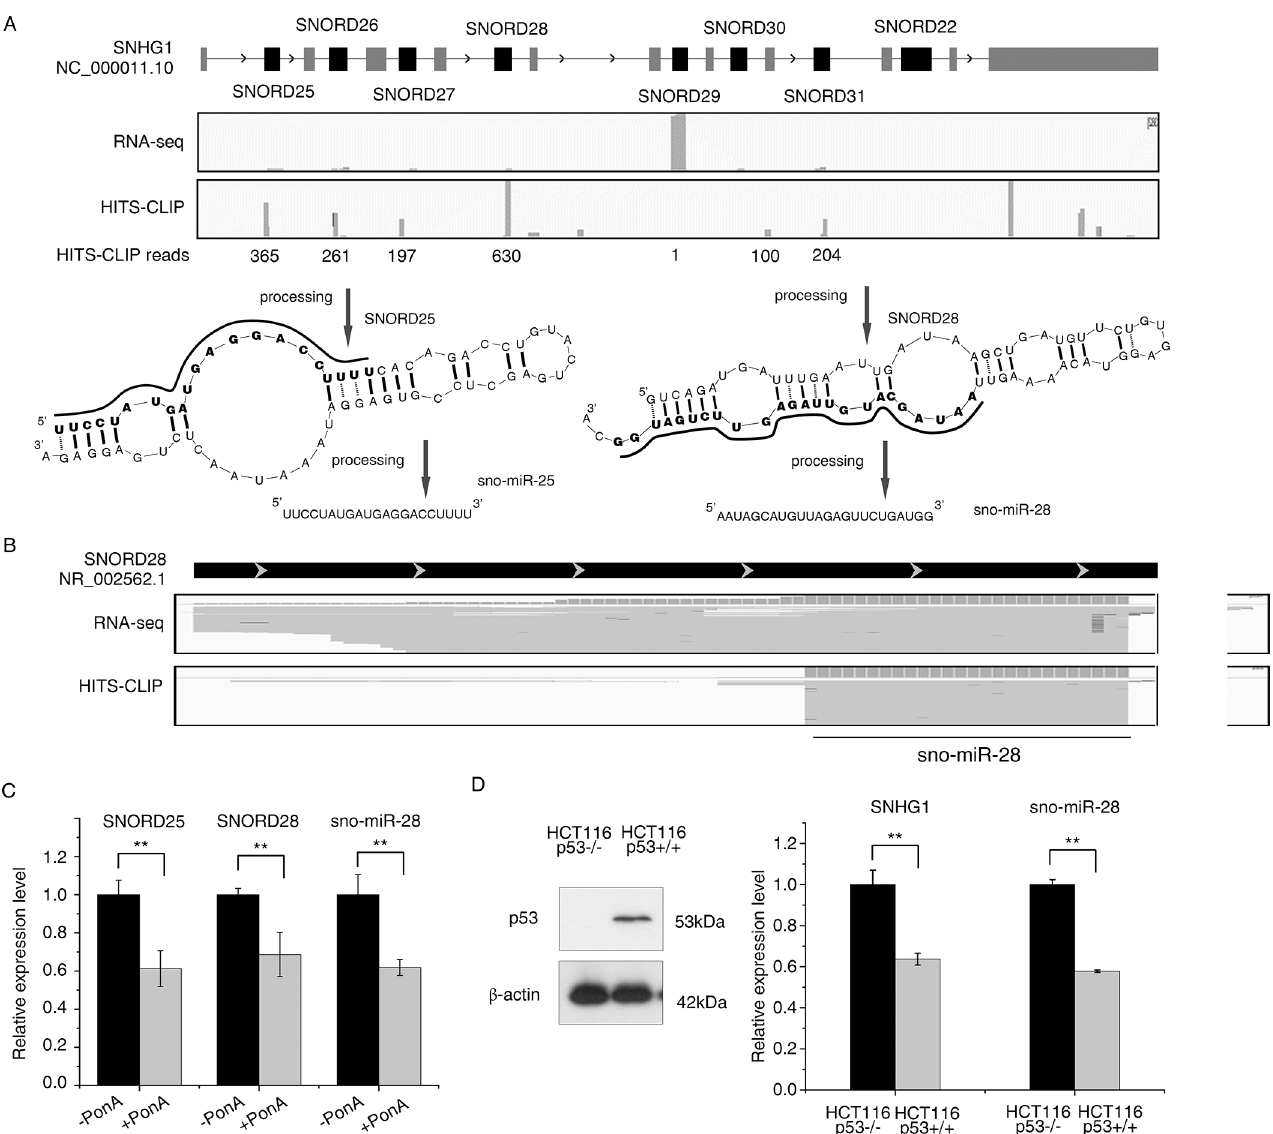
Fig 2. p53 repressed snoRNAs are processed into miRNAs. (A) SNHG1 is processed into snoRNAs including SNORD25 and SNORD28. The top panel shows RNA deep-sequencing and HITS-CLIP (high throughput sequencing of crosslinked and immunoprecipitated RNA) results at the SNHG1 genomic loci. Predicted stem-loop folding of SNORD25 and SNORD28 are shown. The regions marked in bold are processed into sno-miRNAs which can bind to Argonaute proteins, which was confirmed by RNA deep-sequencing and HITS-CLIP results. The solid lines between chains represent hydrogen bonds between adenine (A)-uracil (U) pairs and guanine (G)-cytosine (C) pairs, whereas dashed lines represent G-U pairing. (B) RNA-seq and HITS-CLIP mapping reads across the SNORD28 region is shown indicating precise binding of sno-miR-28 to AGO (C) p53 was induced by PonA treatment in inducible H1299 cells, and the expression levels of SNORD25, SNORD28 and sno-miR-28 were determined using TaqMan assay and RT-PCR. Expression levels of SNORD25, SNORD28 and sno-miR-28 were shown in induced or uninduced cells. (D) Isogenic HCT116 -/-p53 and HCT116 +/+p53 cell lines were used to investigate the relation of SNHG1 and sno-miR-28 expression levels with p53. Left: p53 protein expression in the HCT116 isogenic cell lines was shown by Western blot and β -actin was used as a loading control. Right: SNHG1 and sno-miR-28 expression was determined by RT-PCR as shown. ** p < 0.01 versus controls for all